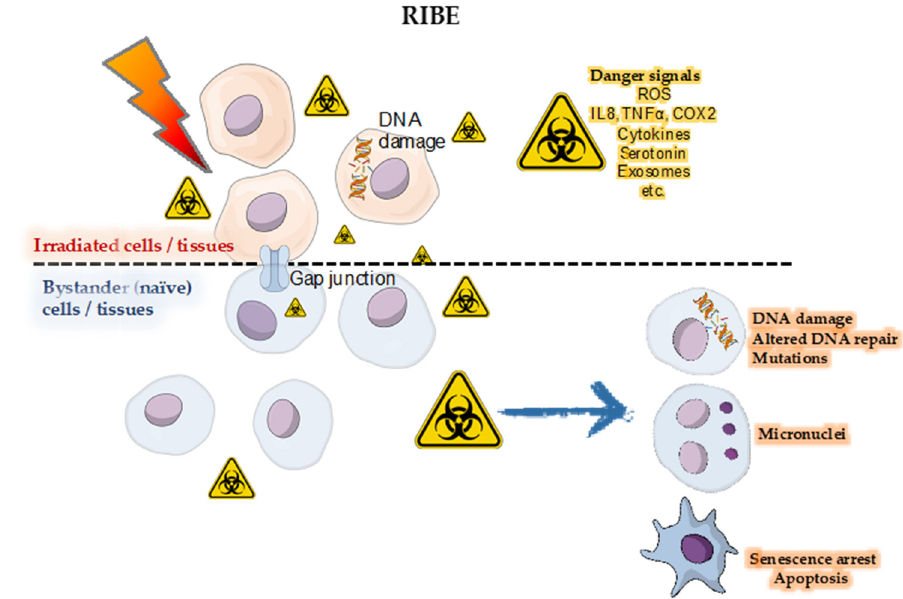
Figure 3. Radiation-induced bystander effect ( RIBE ) . Directly irradiated cells produce danger signals inducing DNA damage and cell death in adjacent, non-irradiated cells. The latter are called bystander or naïve cells.